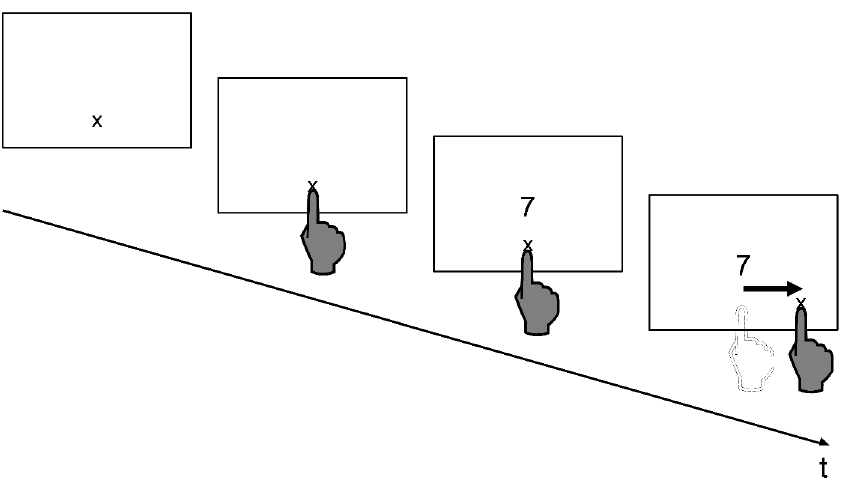
Figure 1. 500 ms after participants placed their finger on the response object, a digit appeared. They responded by swiping the object to the right/left side, depending on the digit’s